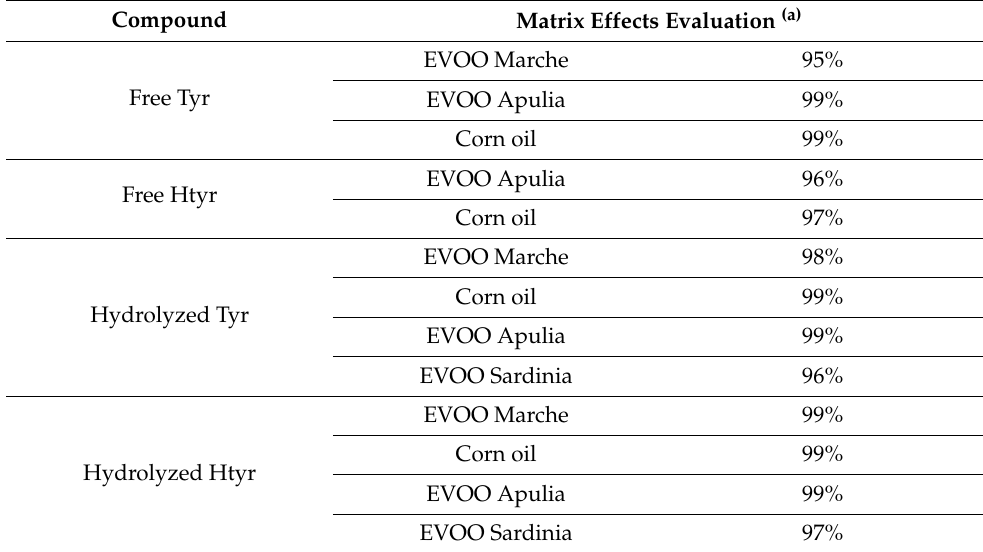
Table 3. Matrix effects evaluation of the quantified EVOO samples.